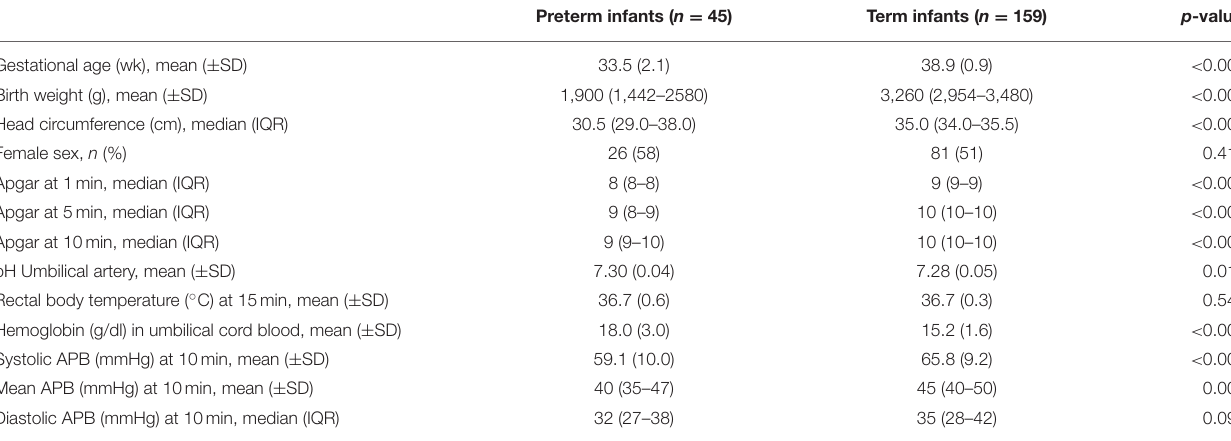
TABLE 2 | Demographic and clinical characteristics of preterm and term